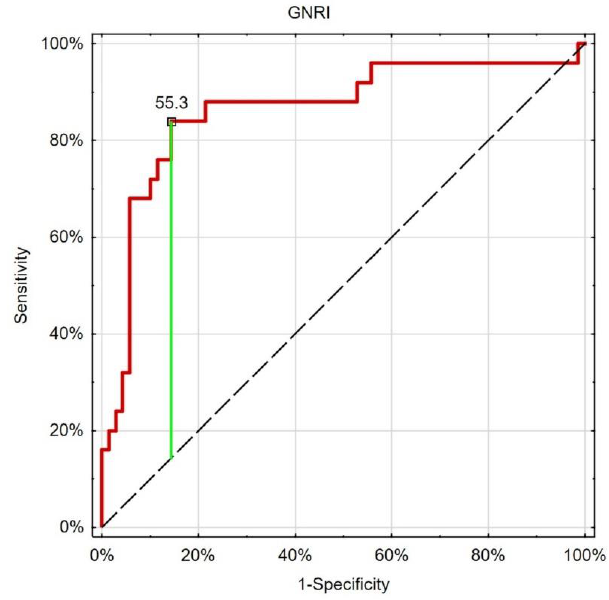
Figure 3. ROC analysis (red line) of GNRI in the differentiation between type 1 or type 2 diabetes, with the best cut-off point based on the Youden index (green line). Black dashed-reference line.